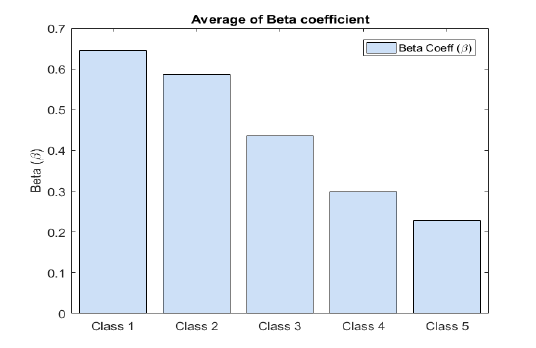
Figure 7. The Bar Chart of Beta Coefficient Mean in Five